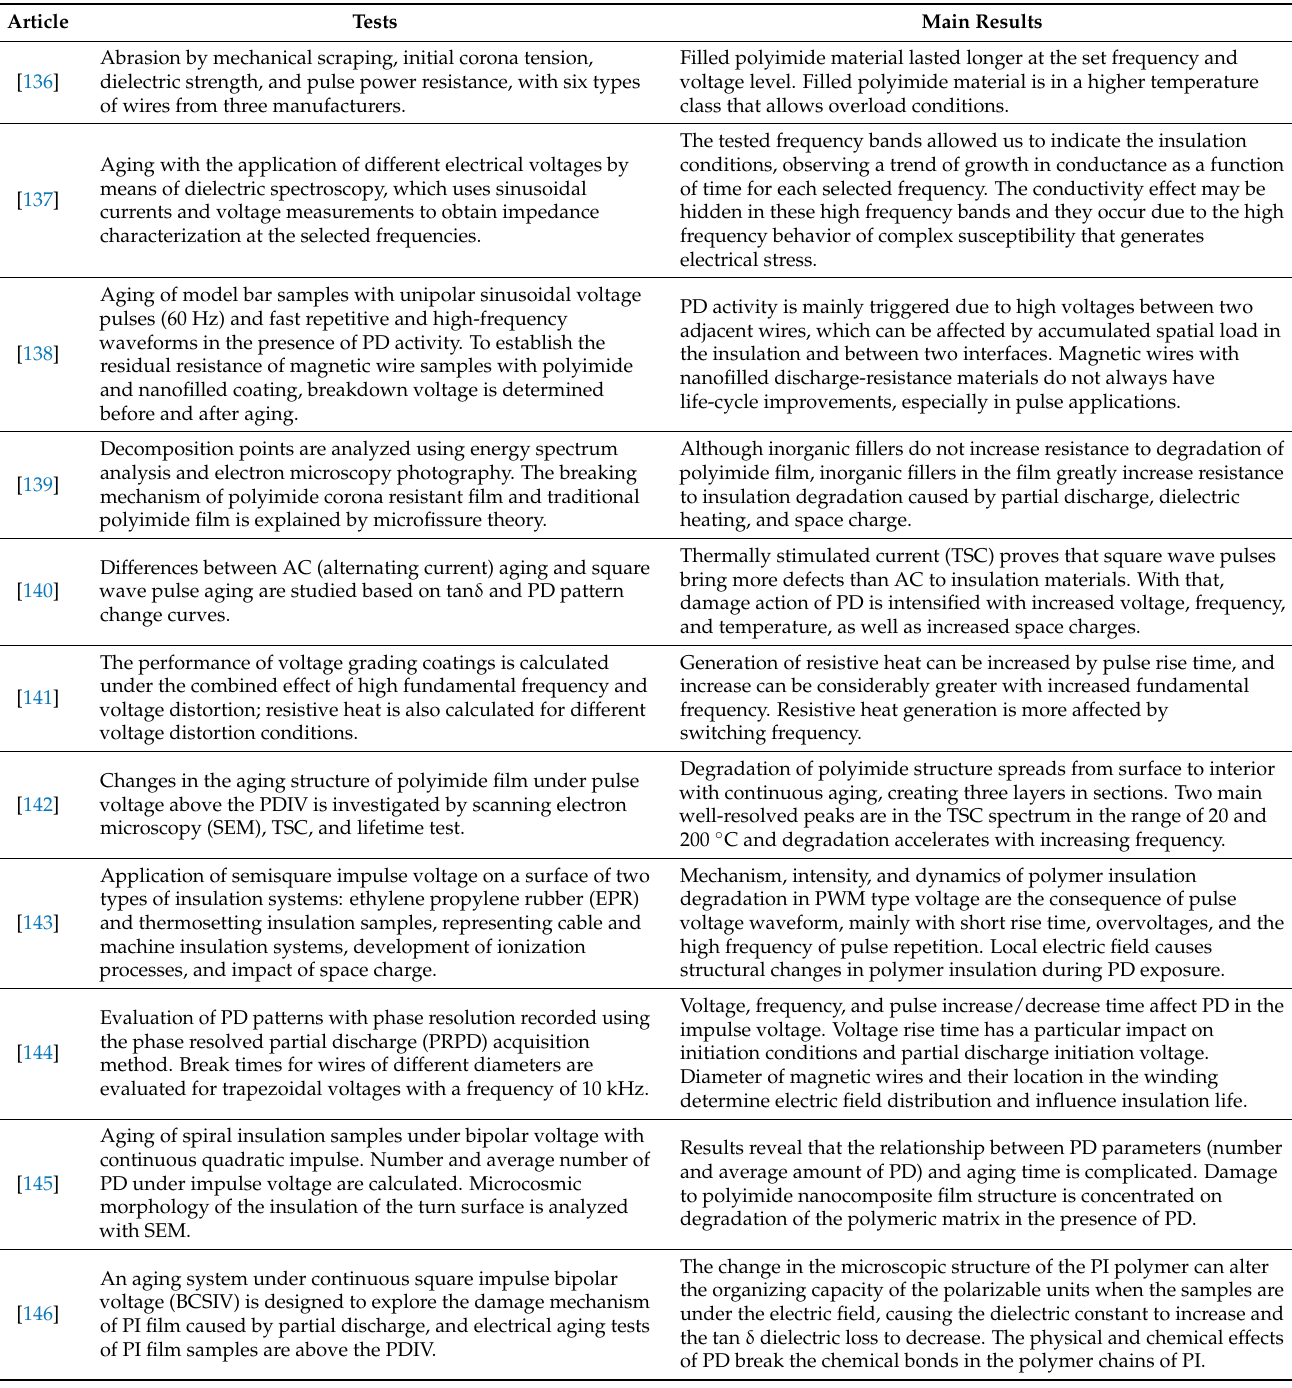
Table 6. Summary of contributions presented in each article in this